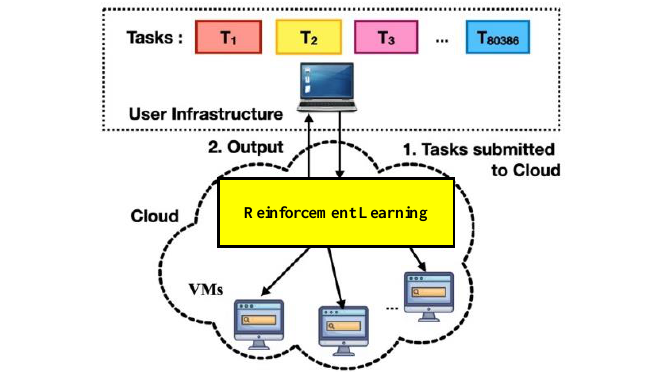
Figure 2. Proposed Reinforcement Learning to improve resource